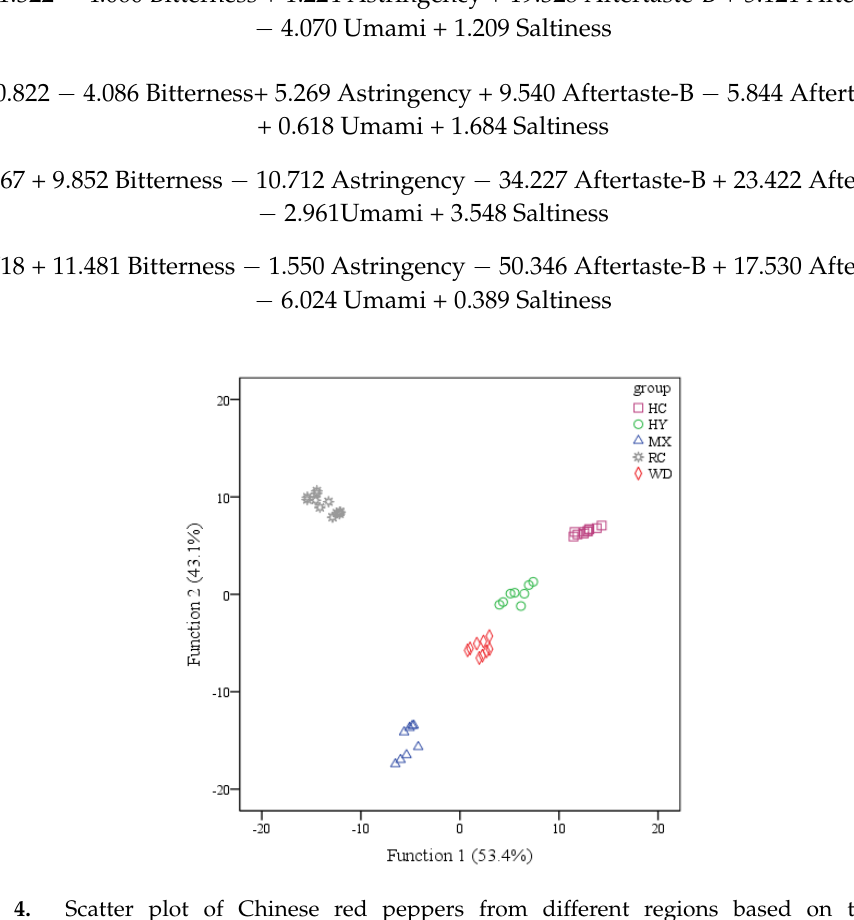
Figure 4. Scatter plot of Chinese red peppers from different regions based on the two discriminant Scatter plot of Chinese red peppers from different regions based on the two functions. discriminant